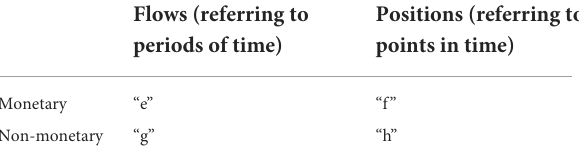
TABLE 1 Categories of approaches to decision-making and sustainability assessment. Ethically/ Ethically/ ideologically closed ideologically open Highly aggregated “a” “b” Highly disaggregated“c” “d” Source:Söderbaum(2008a,p.1472). TABLE 2 Categories of indicators (impacts) for sustainability monitoring and assessment. Flows (referring to Positions (referring to periods of time) points in time) Monetary “e” “f” Non-monetary “g”